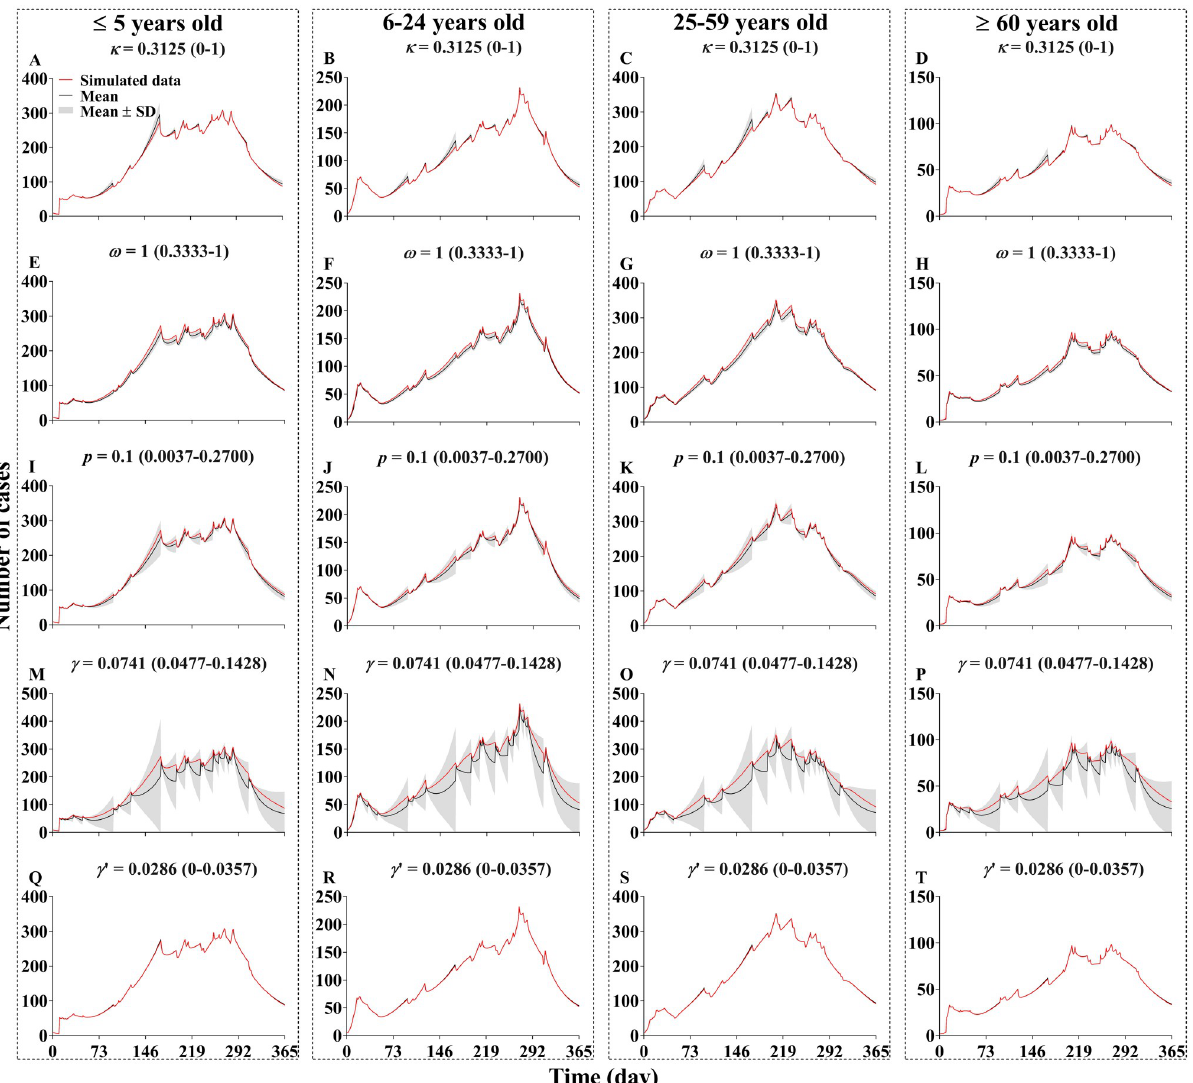
Fig 11. The sensitivity analysis of five parameters κ , ω , p , γ , and γ ’. The red line shows the simulation result of the actual value in our model, and the black line and shadow gray band indicate the mean and standard deviation reserved after simulating 1000 times according to the value range of each